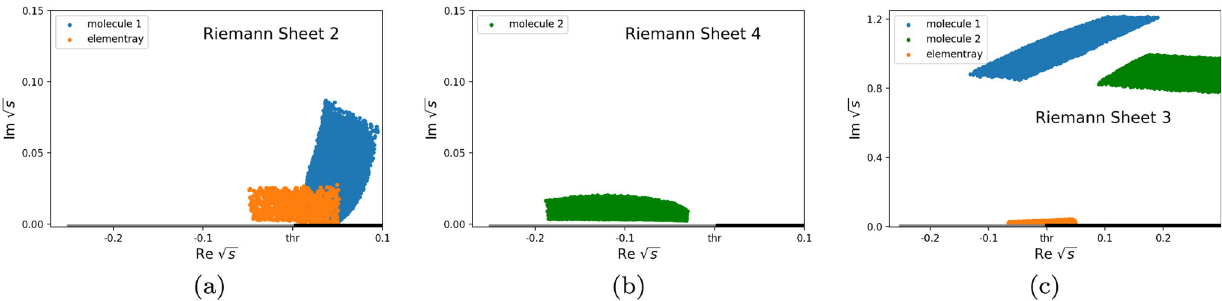
Fig. 1 Pole positions for “elementary” states and molecular states in different Riemann sheets. Here “molecule 1” means a molecular bound state and “molecule 2” means a molecular virtual